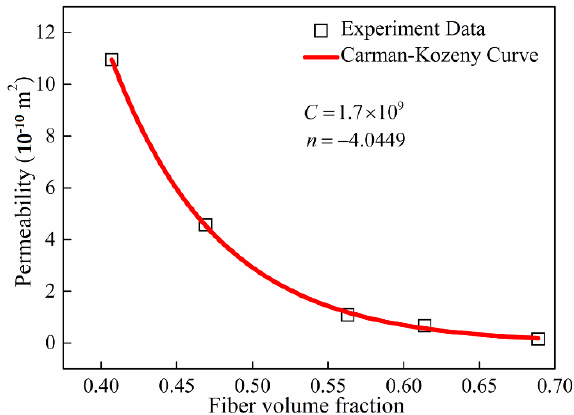
Figure 3. Permeability curve with varying fiber volume fractions.